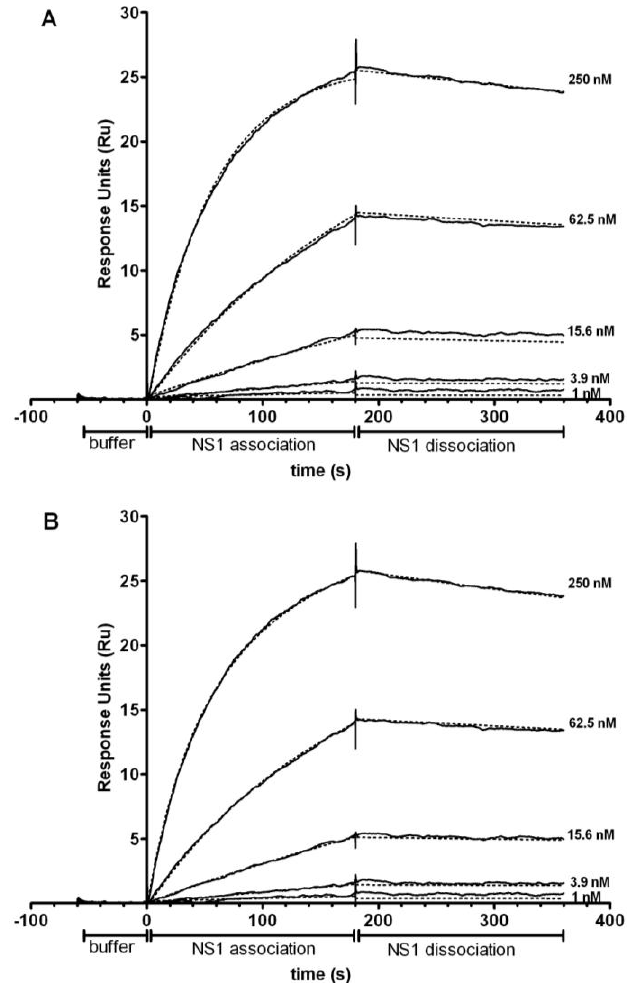
Figure 3. Representative sensorgrams of the interaction between injections of a DENV NS1 mAb (Dv3 M7) at varying concentration with immobilized DENV-3 NS1 protein. ( A ) Fitted as a 1:1 interaction model, ( B ) Fitted using a bivalent analyte model. The dotted lines represent the fitting of the original sensorgrams (black